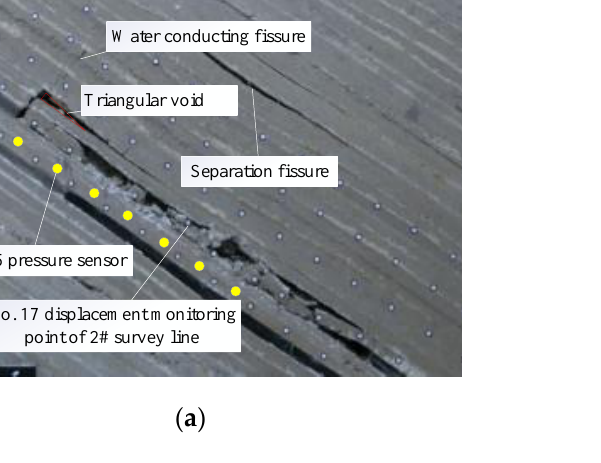
Figure 6. Migration characteristics of overburden under mining. ( a ) Mining 90 m in the top mining face; ( b ) vertical displacement of upper coal overburden.